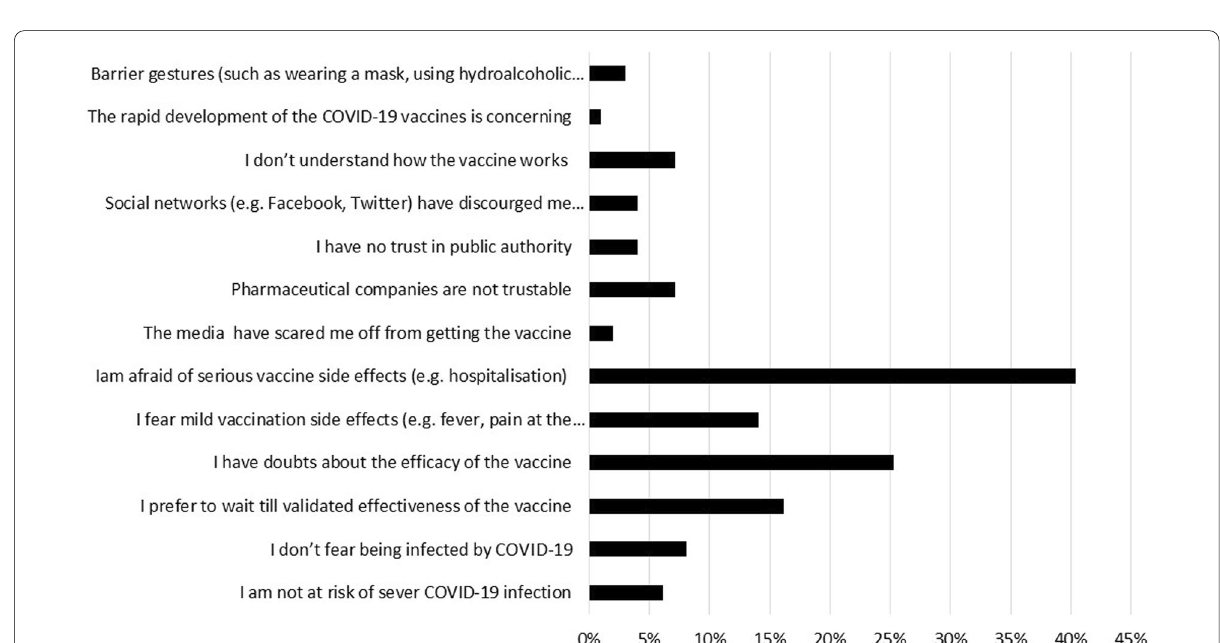
Fig. 3 Hemodialysis patients’ barriers explaining COVID-19 vaccine hesitancy or resistance [ n